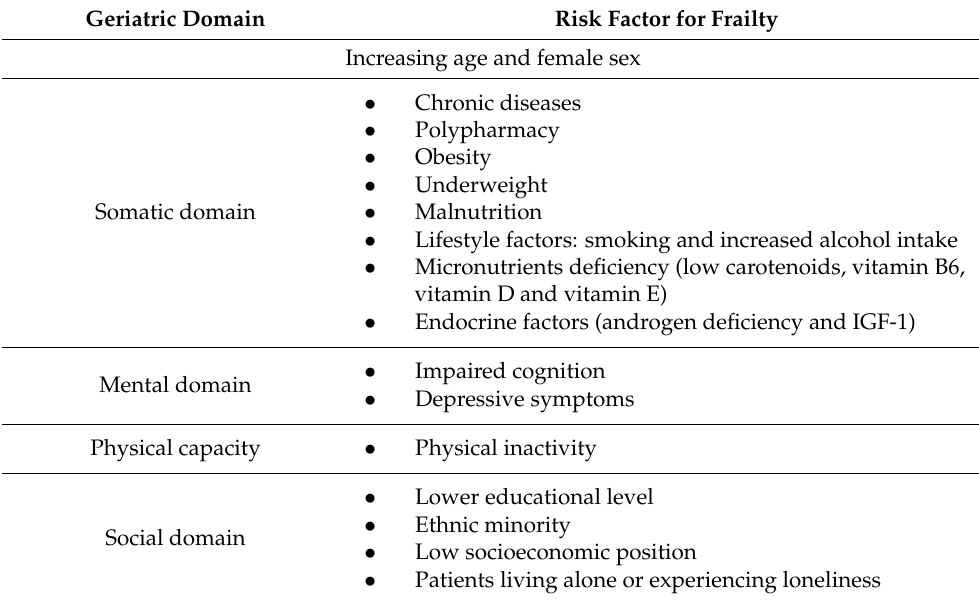
Table 4. Risk factors for frailty in community-dwelling older adults categorized by geriatric